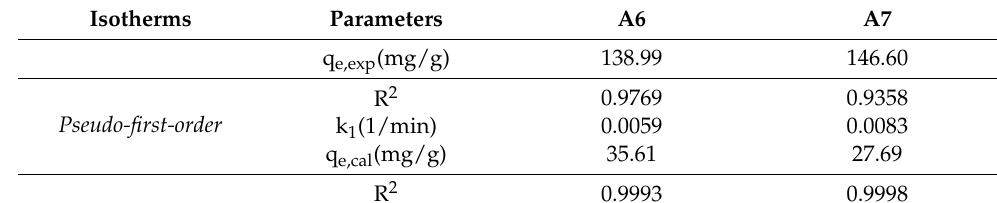
Table 7. Kinetic parameters for the adsorption of methylene blue. Figure 9. Influence of contact time on the adsorption of methylene blue on samples A6 andA7 (bi ‐ ochar mass: 20 mg, initial dye solution concentration: 60 mg/L, volume of methylene blue solution: 50 mL, temperature: 22 ± 1 °C).